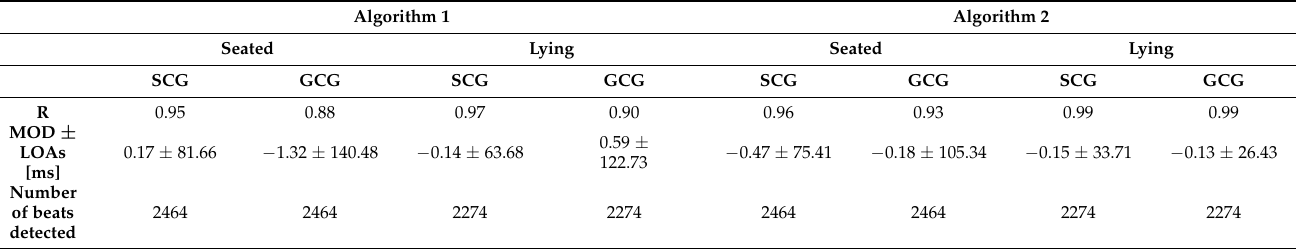
Table 1. IBI analysis: R coefficients, MOD and LOAs